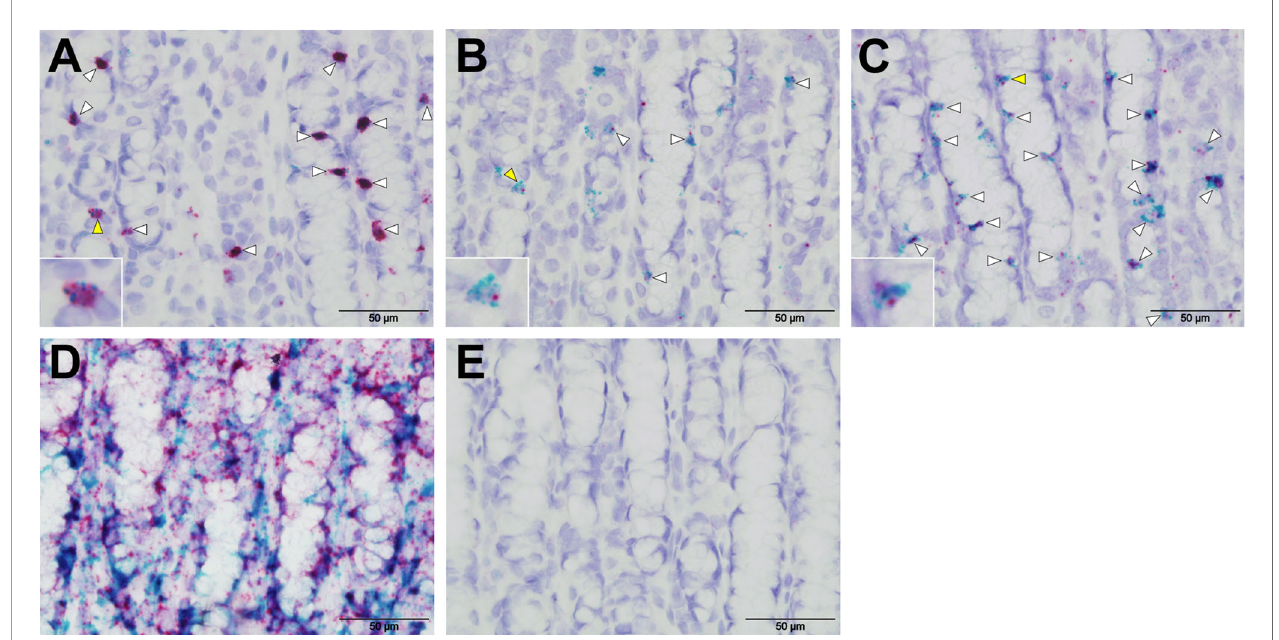
FIGURE 7 | RNAscope validates scRNA-seq of ovine tuft cell gene expression. Co-expression of probes to POU2F3 (green) and (A) IL-17RB (B) TASR16 (C) DCLK-2 (all red) in ovine abomasal tissue following H contortus infection. Arrowheads show probe co-localization, with yellow arrows indicating the cells represented in the insets. (D) Signal from positive control probes to ovine beta actin ( actb , green) and ovine peptidylprolyl isomerase ( ppib , red). (E) No labelling with negative control probe DapB from Bacillus subtilis